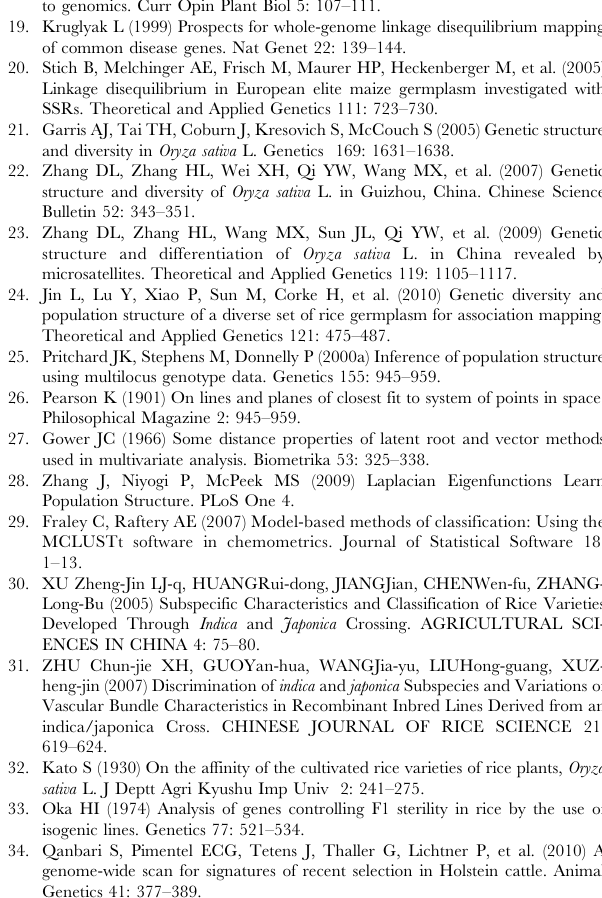
germplasm type. Vertical lines at each point indicate standard error which was calculated by bootstrapping across genotypes. Vertical lines at the x axis indicate genetic map positions of the SSR loci on the chromosome. Figure S6 Modified Roger’s distance (MRD) between indica and japonica rice across the rice genome. Dashed lines indicate average MRD across the genome and dotted lines average MRD for each chromosome. Vertical lines at each point represent the standard error multiplied by 10 which were calculated by bootstrapping across genotypes. Vertical lines at the x axis indicate genetic map positions of the SSR loci on the chromosome. Figure S7 LD decay plot within the subgroup. Squared correlations of allele frequencies ( r 2 , blue triangles) and weighted standardized disequilibrium coefficient ( D ’, red triangles) against genetic distance(cM) between linked loci in SG 1 (A) and SG 2 (B). The horizontal line indicates the 75th percentile of r 2 for unlinked loci. Table S1 Accessions, variety names, origin, germplasm types, and Cheng’s index of 150 rice varieties in the core collection. The varieties were sorted according to their STRUCTURE membership probability as Figure 1(a). Indica or